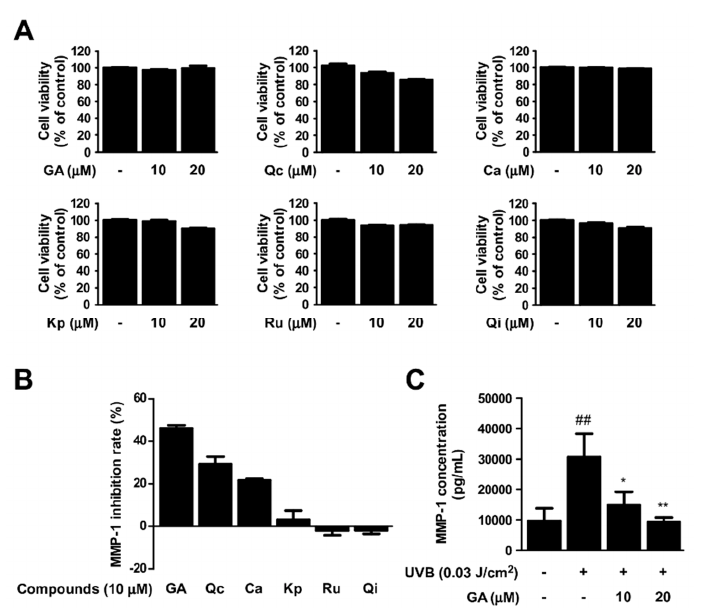
Figure 5. Effect of single compounds in RPE on UVB − induced MMP − 1. ( A ) Cell viability was measured after cells were treated with gallic acid (GA), quercetin (Qc), catechin (Ca), kaempferol (Kp), rutin (Ru), Quercitrin (Qi) for 48 h ( n = 5). ( B ) Human dermal fibroblasts (HDFs) were pre − treated with compounds at the indicated concentrations for 1 h before being exposed to UVB. After 48 h, MMP − 1 production in cultured media was measured using ELISA ( n = 3). Data represent MMP − 1 inhibition rate compared to UVB − only treatment group. ( C ) HDFs were pre − treated with gallic acid (GA). MMP − 1 concentration was measured using ELISA ( n = 3). Data represent the means ± SD. Significant differences between un − treated control and UVB − only treatment group (## p < 0.01) and significant differences between UVB and UVB + GA treatment group (* p < 0.05, ** p < 0.01).